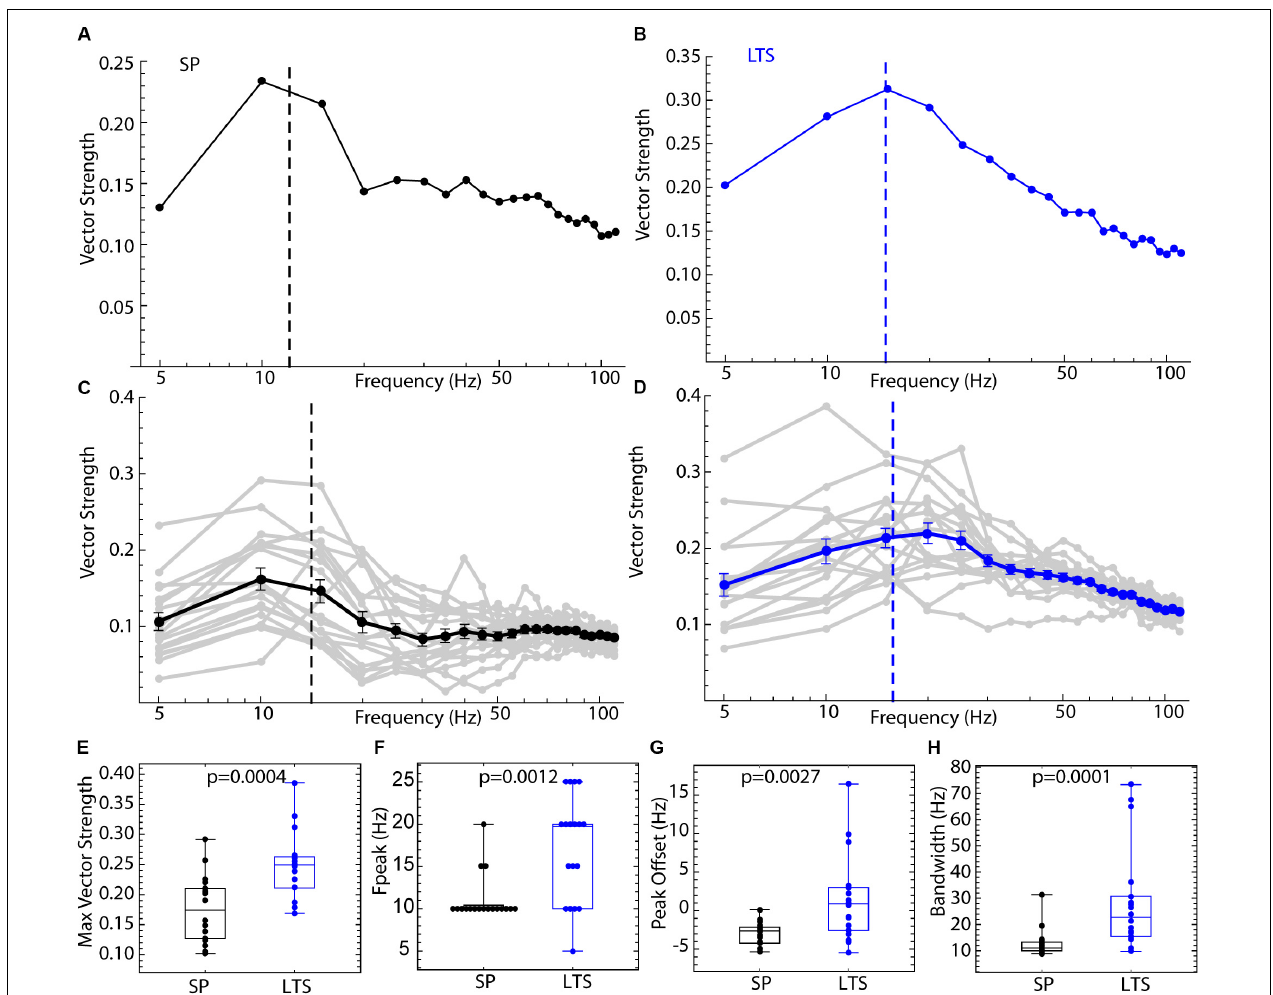
FIGURE 9 | Spiking resonance for broadband input in the phase model. For each of the 18 LTS interneurons and 18 SP neurons, the experimental PRC and unperturbed firing rate were used to generate spike trains in response to pulsed noise stimuli like those used to measure spiking resonance in the real cells. (A) An example spiking resonance spectrum from a phase model based on an SP neuron. The cell’s firing rate is indicated by the dotted line. (B) An example phase model LTS interneuron shown the same way. (C) Superimposed spiking resonance spectra (gray) and the average spiking resonance (black) for 18 SP phase model neurons. (D) Superimposed individual spectra (gray) and average spectrum (blue) for phase models based on all 18 LTS interneurons. Error bars are standard errors of the mean at each frequency. The dotted lines indicate the average firing rates for the two groups of cells. (E) Model LTS interneurons showed a higher vector strength overall than model SP neurons. (F) The frequency at the peak resonance was higher in model LTS interneurons. (G) The difference between the firing rate and peak frequency for each cell was greater in model LTS interneurons. (H) The bandwidth of resonance (measured as shown in Figure 2 ) was greater in model LTS